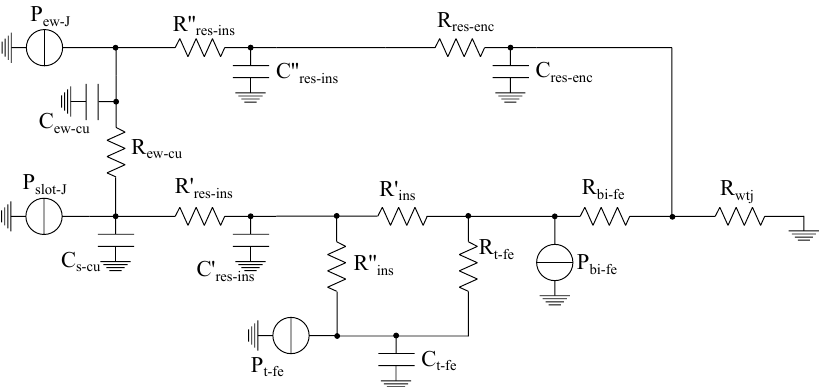
Figure 11. Thermal network for the analysis of the dynamic thermal behavior of the electric motor.